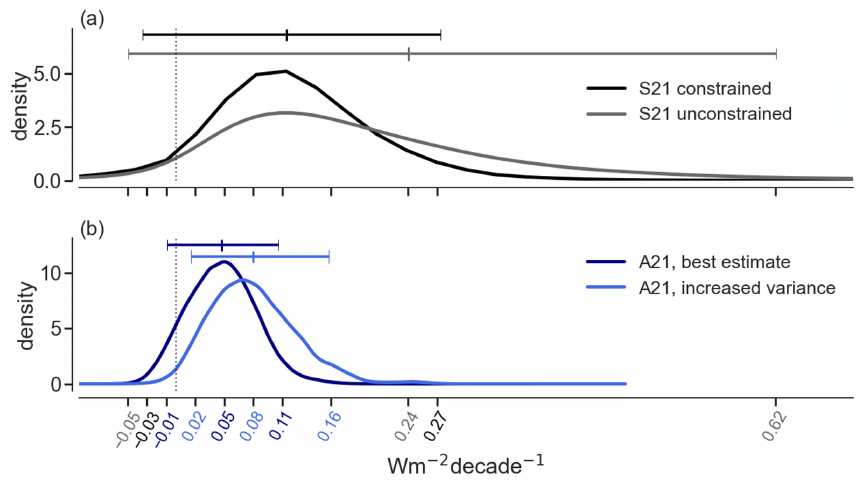
Figure 5. Assessment of the linear trend in ERFaer between 2000 and 2019. Panel (a) as in Smith et al. (2021a, their Fig. 7; abbreviated as S21 in the labels), and panel (b) as in Albright et al. (2021, labelled A21). The constraint is as in the cited studies, but applied to the period 2000–2019. Increased variance in Albright et al. (2021) corresponds to a scenario prescribing internal climate variability that is a factor of 5 larger than the CMIP6 mean and assuming large, correlated errors in global temperature observations, yielding a fifth-percentile ERFaer lower bound of − 1 . 8Wm − 2 . The labels along the x axis correspond to 5% and 95% percentiles, as well as mean, of the distribution of the curves in the corresponding colour. Table 1. Values corresponding to Fig. 6. The trends in absolute units are reported in Supplement Table